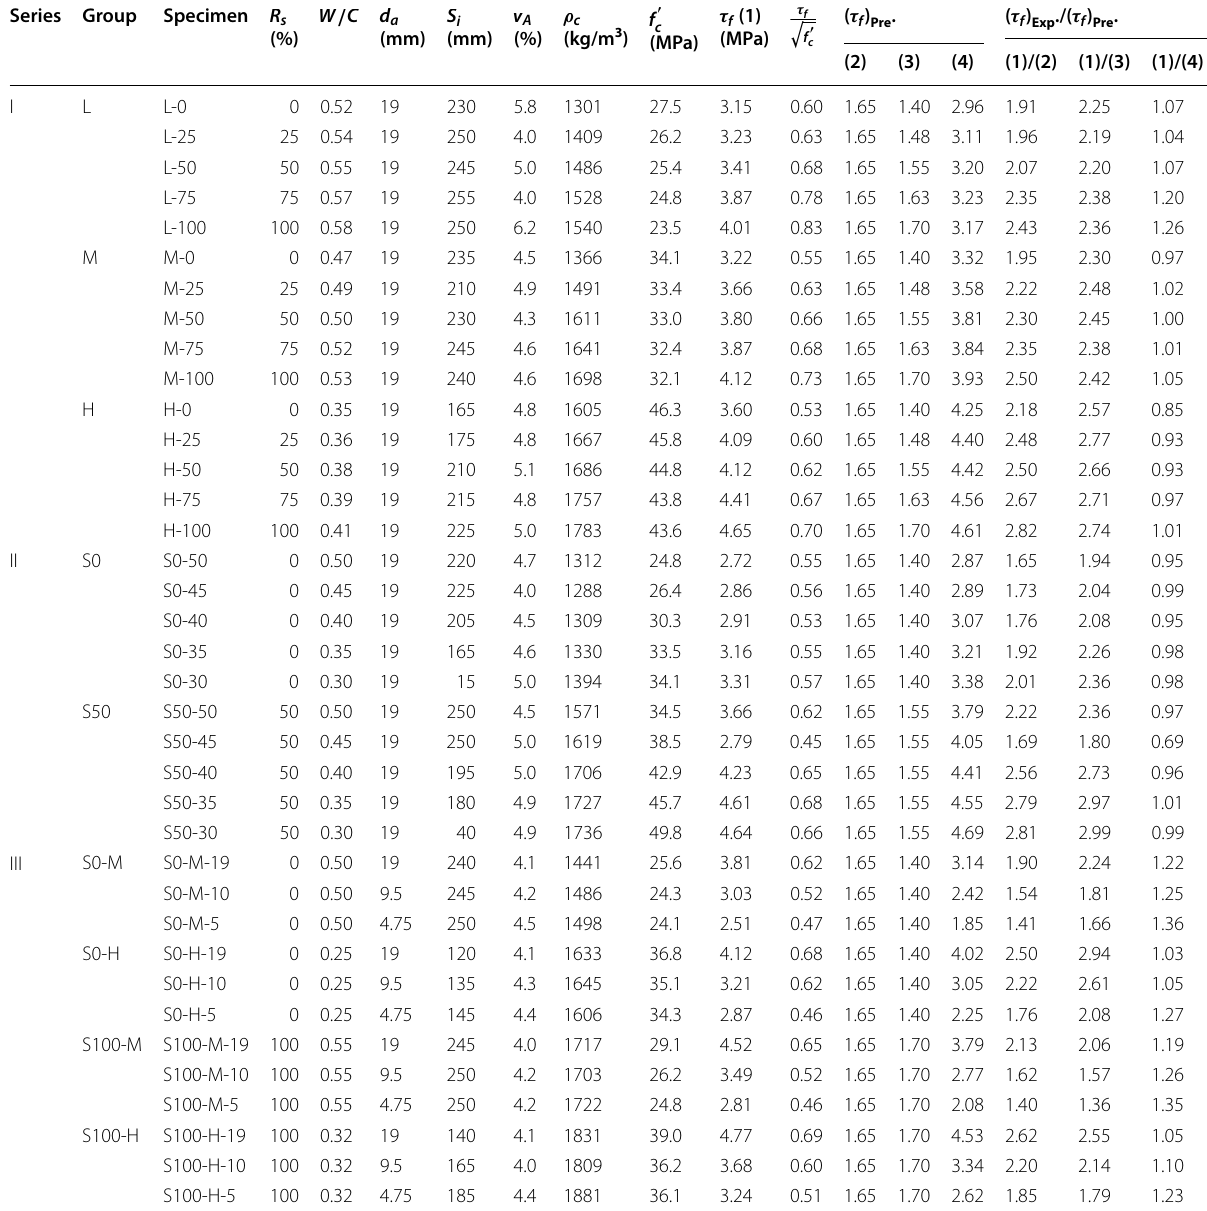
Table 3 Summary of test